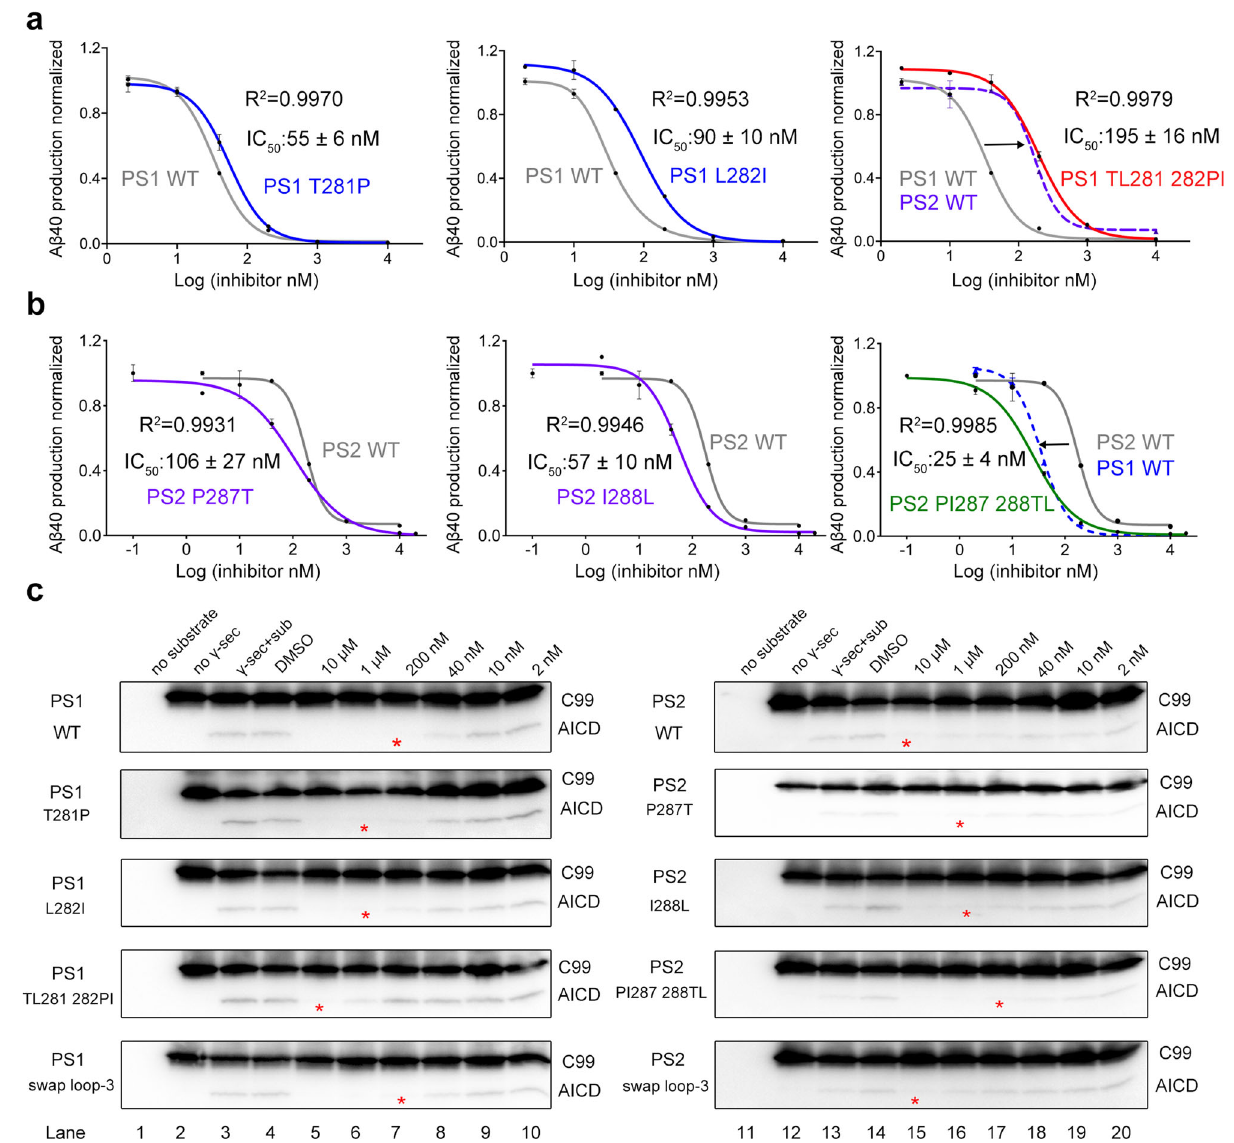
Fig.4|Thr281andLeu282ofPS1determinetheisoformselectivityofMRK-560. a – c Individual and double residue swapping of Thr281 and Leu282 in PS1 with the corresponding Pro287 and Ile288 in PS2 alter their respective sensitives to MRK- 560accordingly.IC 50 valuesforMRK-560inhibitionoftheindicatedPS1( a )andPS2 ( b ) mutants were measured using the AlphaLISA assay that detects A β 40 produc- tion. Please refer to Methods for experimental details. Data are presented asmean values±SD. c Production of AICD by residue-swapped PS1 and PS2 mutants. The